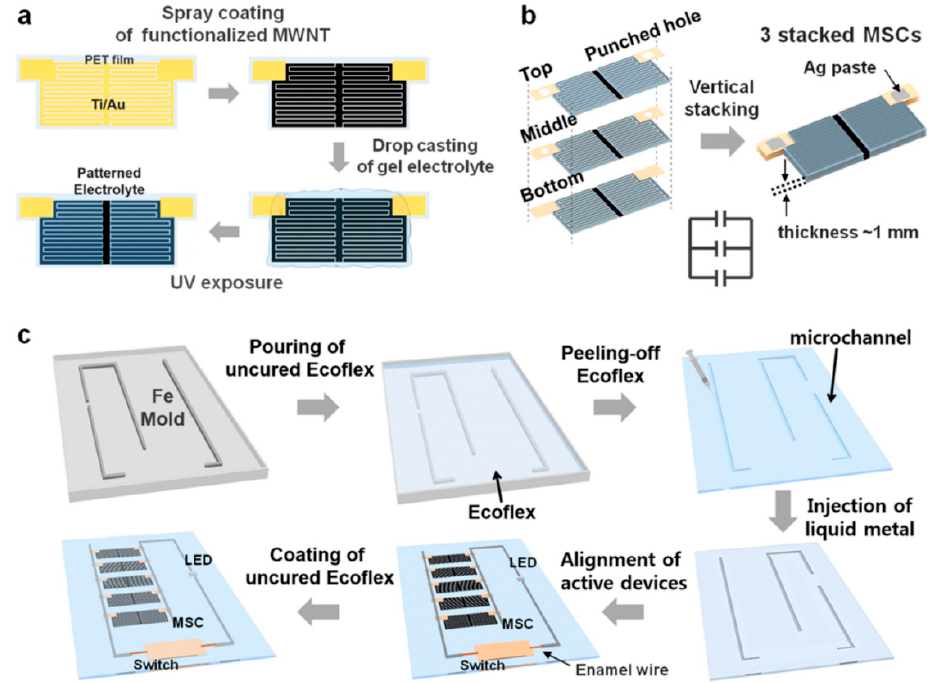
Figure 10. Schematic diagram of spray printing CNTs ink to prepare the micro supercapacitors. ( a ) Sprayed a micro-supercapacitor on the substrate; ( b ) Stack of three spray printed micro supercapacitors; ( c ) Spray printing a micro supercapacitor array on the substrate. Reproduced from [63], with permission from American Chemical Society, 2016.